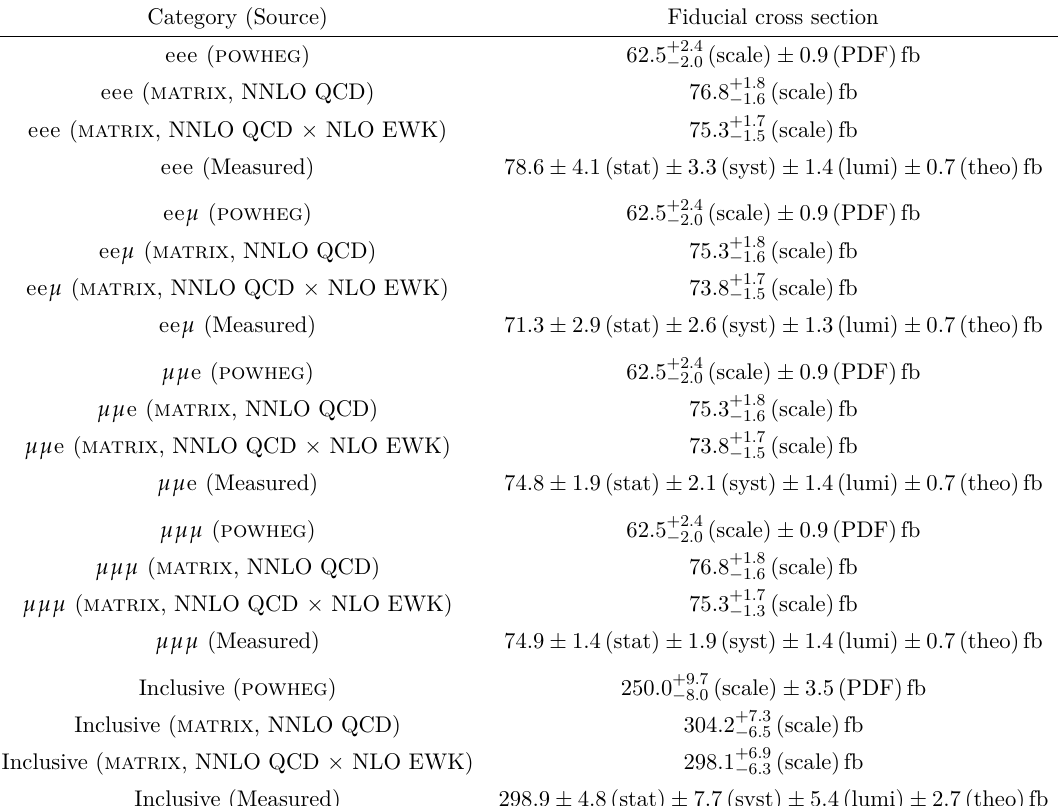
Table 5 . Measured fiducial cross sections and their corresponding uncertainties for the flavour- exclusive and flavour-inclusive categories. The predictions from both powheg at NLO in QCD and LO EWK as well as several ones obtained from matrix (NNLO QCD, NNLO QCD × NLO EWK) are also included.